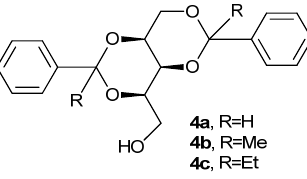
Figure 3. Xylitol based di ‐ O ‐ benzylidene acetal, 4a and ketals, 4b,c . Table 1. Gelation abilities of compounds 4a–c in different hydrocarbon solvents a .